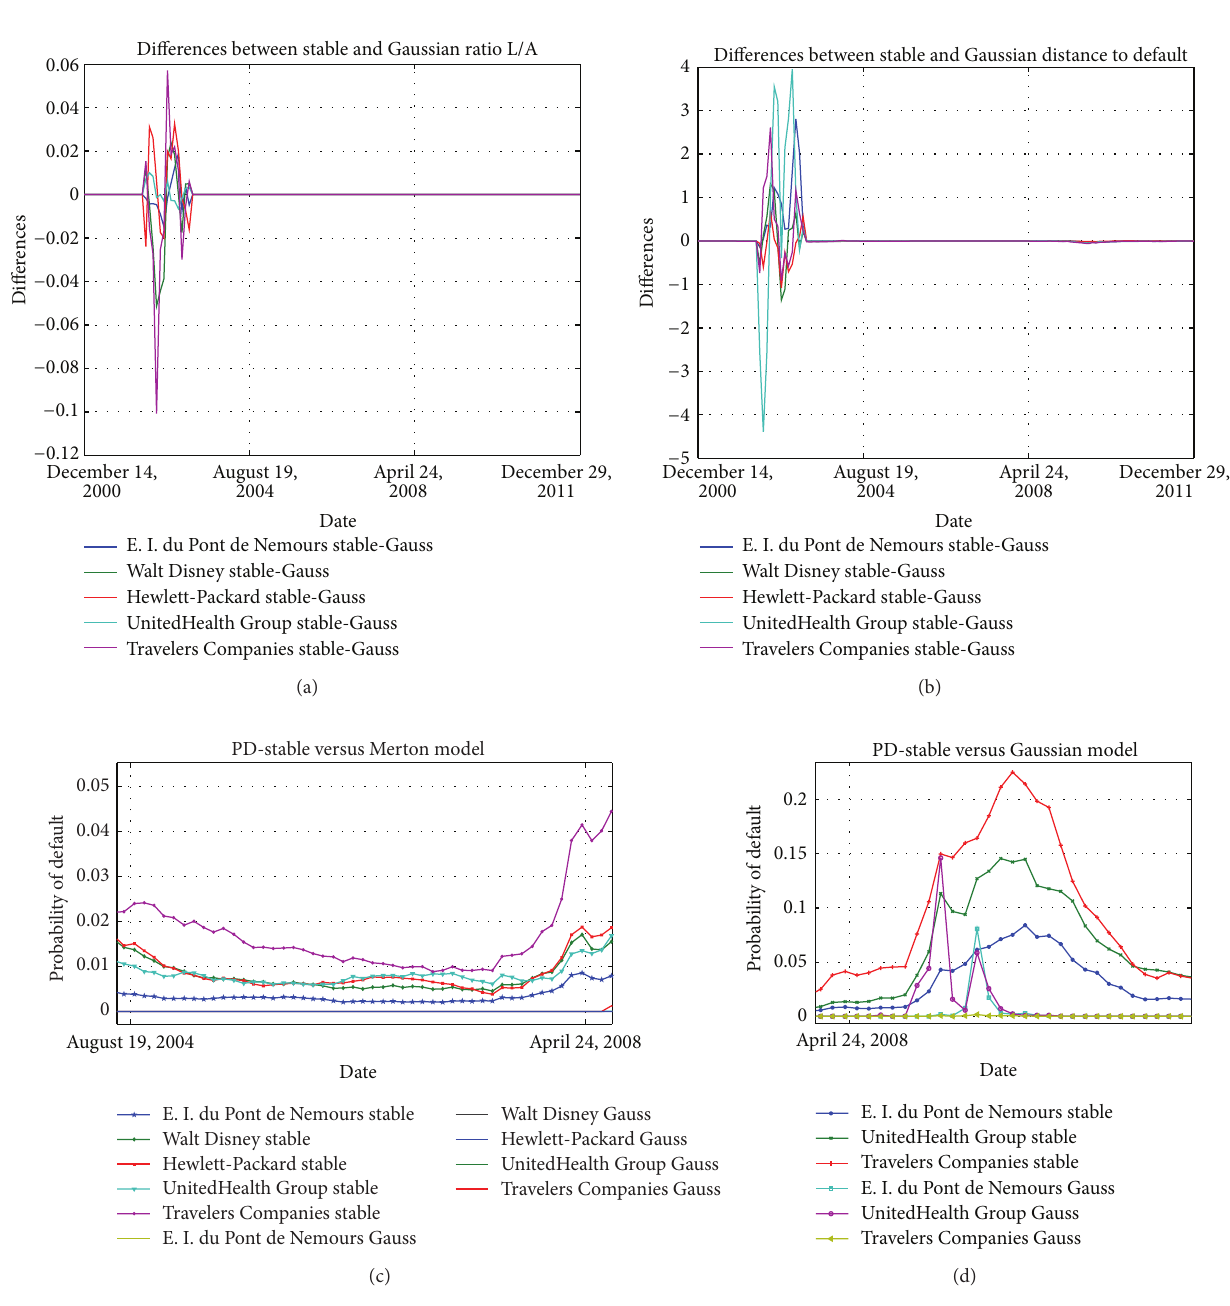
Figure 3: Differences between Stable L´evy model and KMV-Merton model. (a) Difference between stable ratio 𝐿/𝐴 and Gaussian ratio. (b) Difference between the stable and Gaussian distance-to-default. (c) Probabilities of default during “calm periods.” (d) Probabilities of default during the